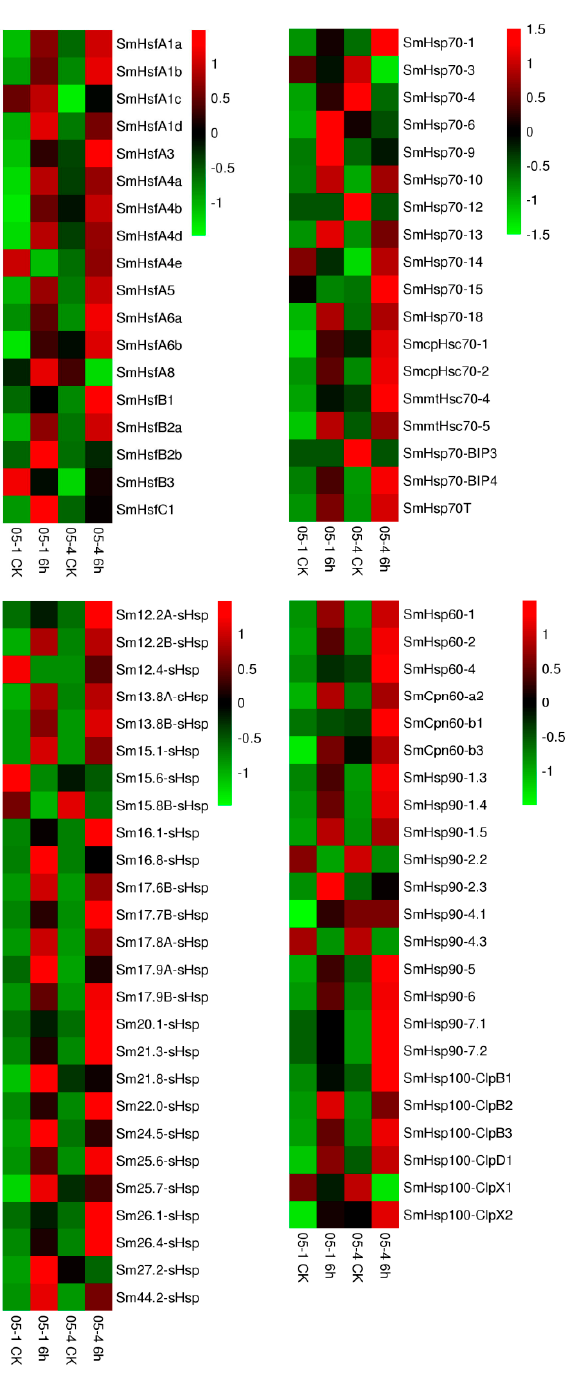
Figure 3. Expression analysis of eggplant Hsf and Hsp genes. Raw data were from RNA-seq data, in response to HS treatment in 05-1 and 05-4 leaves. HS treatment: 42 °C for 6 h; 05-1: eggplant thermosensitive line; 05-4: eggplant thermotolerant line.